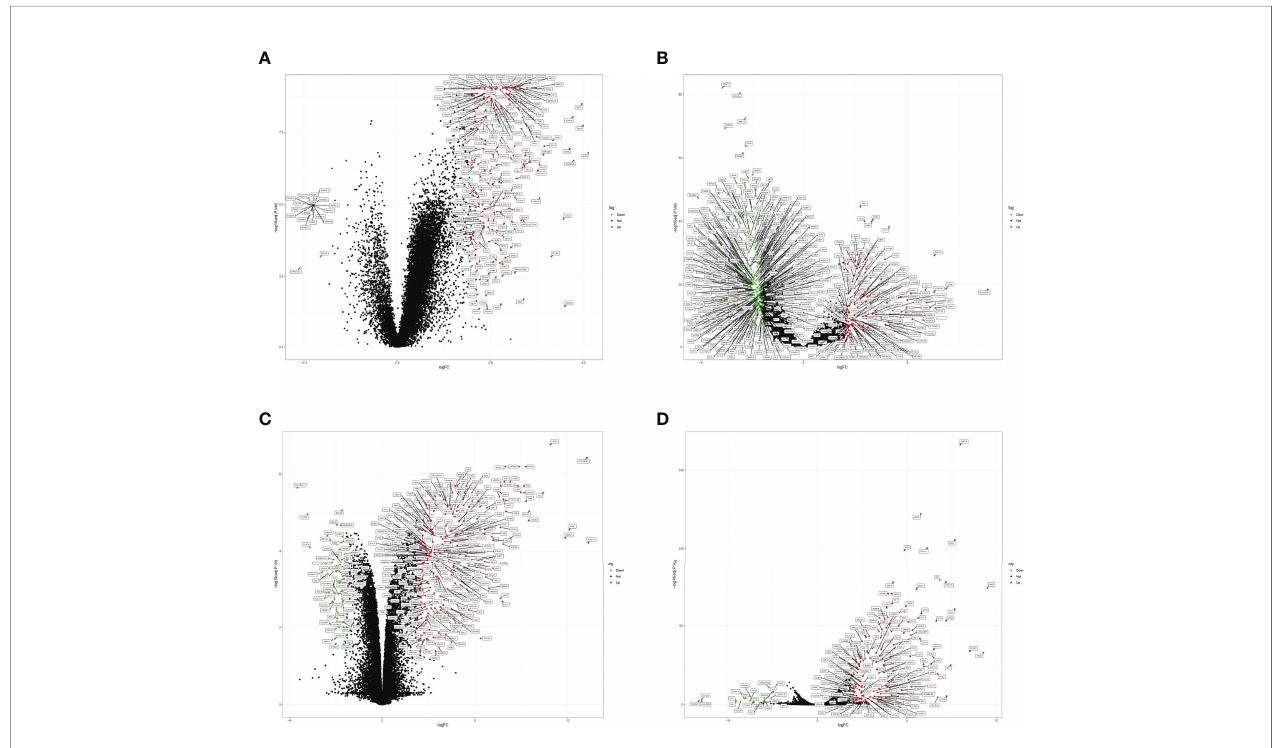
FIGURE 2 | DEGs of COVID-19 and EHF. (A) Volcano plot of DEGs from the GSE157103 dataset. (B) Volcano plot of the DEGs from the GSE152075 dataset. (C) Volcano plot of DEGs from the GSE86282 dataset. (D) Volcano plot of the DEGs from the GSE133751 dataset. Red dots represented up-regulated genes in COVID-19 or EHF patients, and green dots represented down-regulated genes in COVID-19 or EHF patients (FDR<0.05 and absolute value of log(FC) >